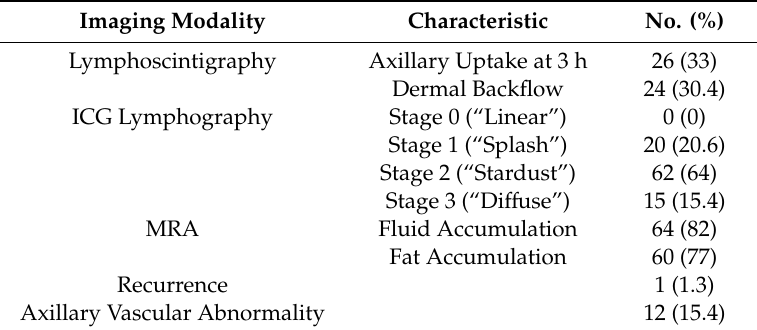
Table 4. Imaging findings in upper extremity